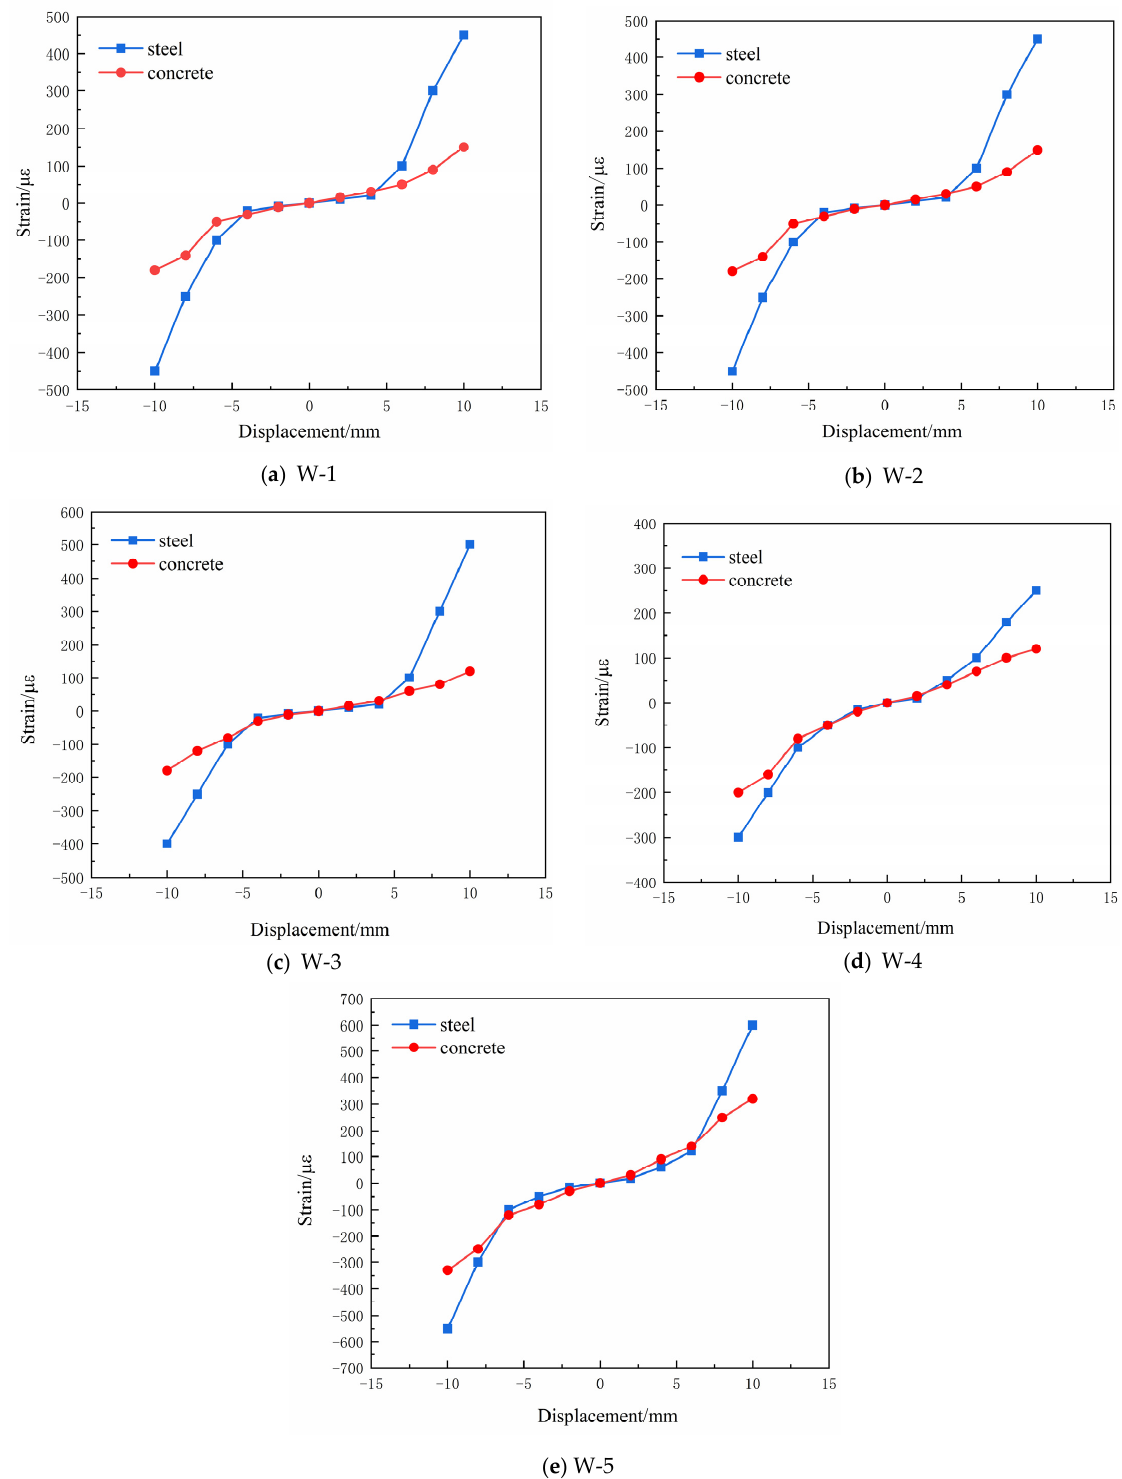
Figure 13. Steel-concrete strain diagram.